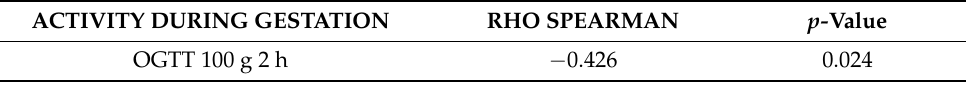
Table A7. Correlation between performing physical activity during pregnancy and the 2 h glucose in the SOG 100 g.